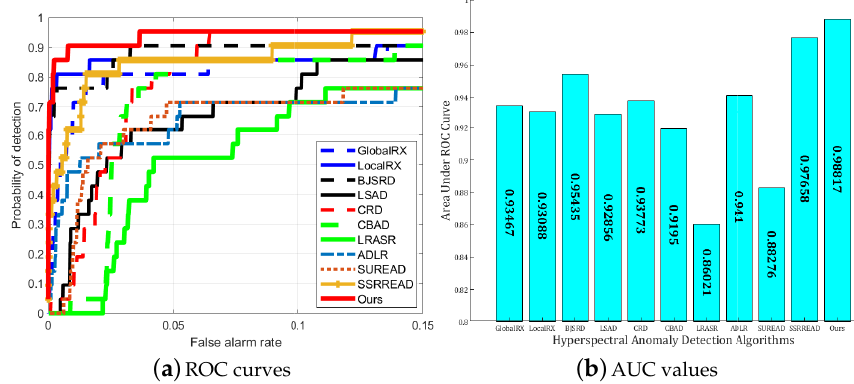
Figure 12. ROC curves and AUC values for the Urban dataset.